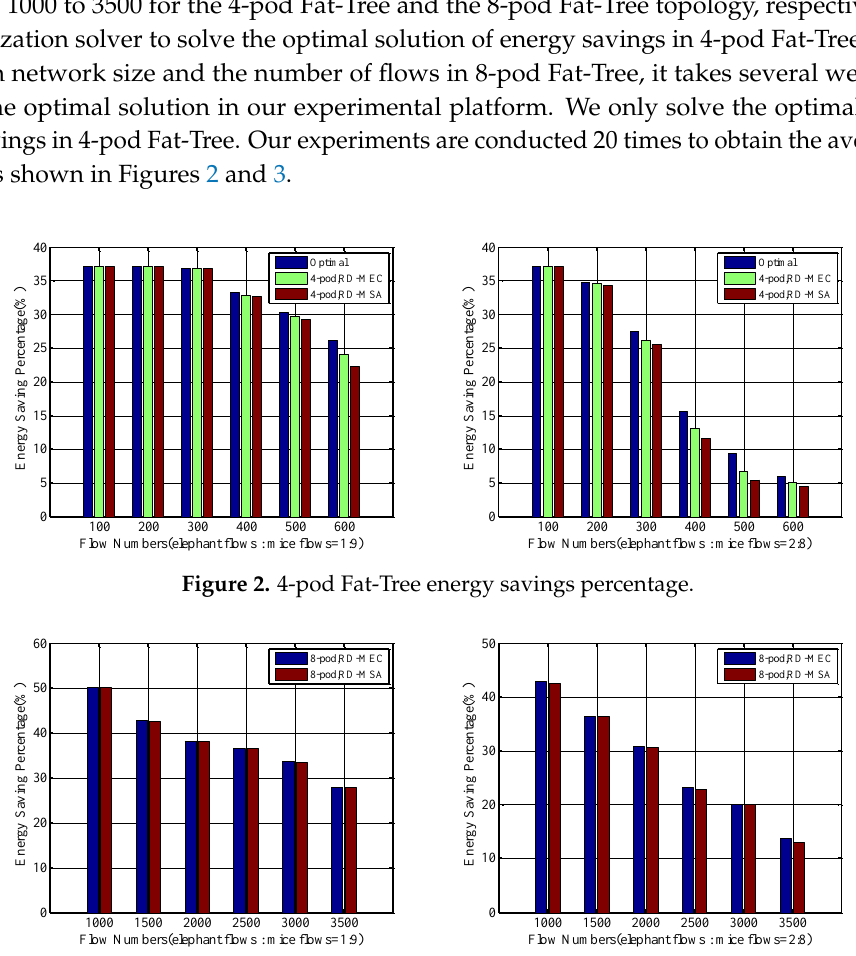
Figure 3. 8-pod Fat-Tree energy savings